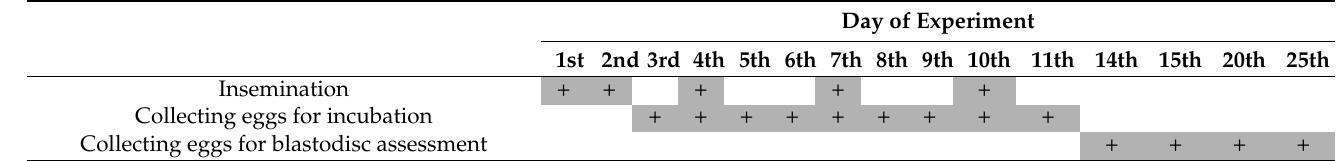
Table 1. Scheme of insemination of hens, collection of eggs for incubation, and collection of eggs to assess the survivability of spermatozoa in the hens’ genital